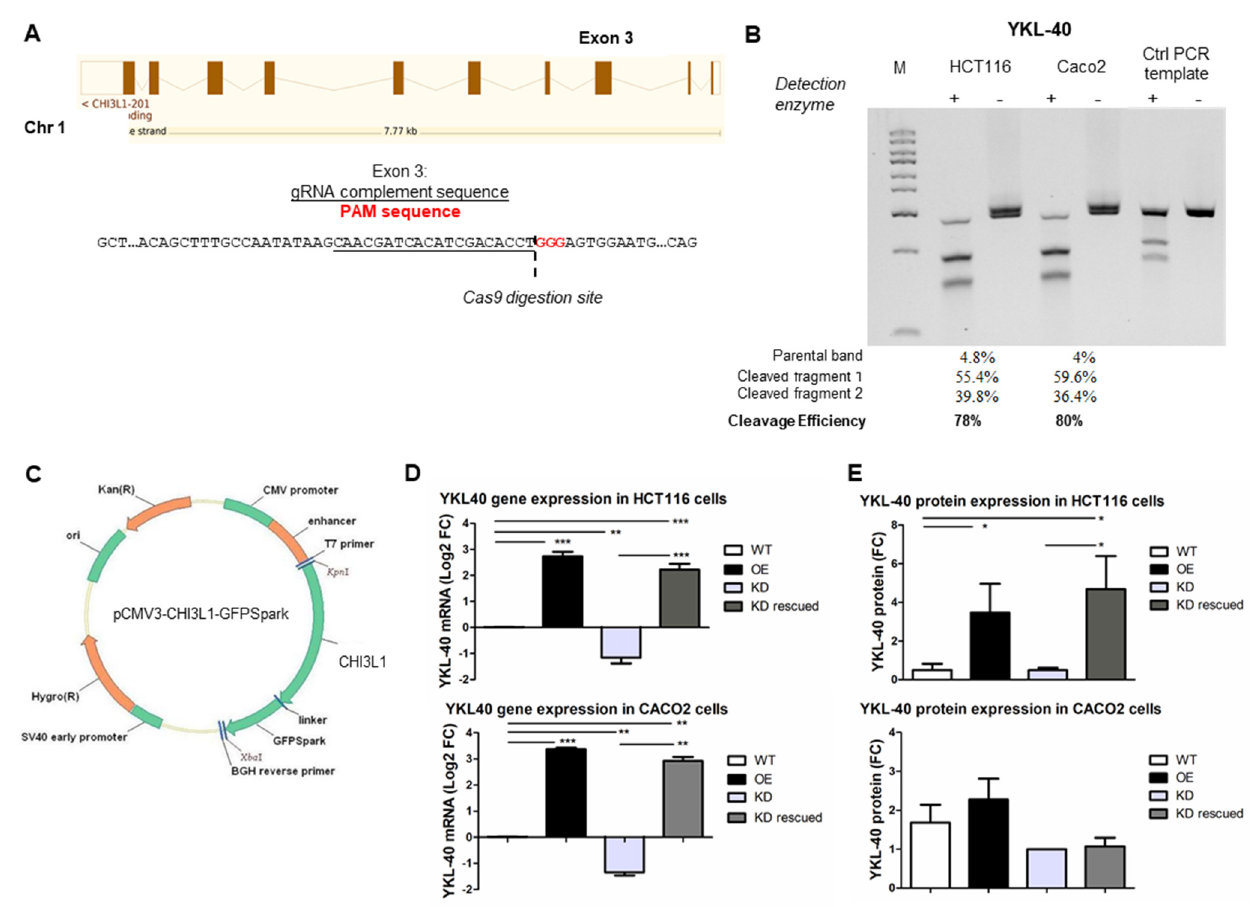
Figure 1. Knockdown and re-/overexpression of YKL-40 in HCT116 and Caco2 cells. ( A ) Knockdown via CRISPR/Cas9 approach is described. Human YKL-40 is located on chromosome 1. The exon 3 sequence is reported, the gRNA complement sequence is underlined, and the PAM sequence is indicated with red nucleotides. ( B ) Gel image of Genomic Cleavage Detection Assay using DNA extracted from transfected HCT116 and Caco2 cells. Control template and primers were included as a PCR technical control. Cleavage efficiency is indicated for each sample. ( C ) Map of pCMV- CHI3L1-GFPSpark plasmid used for YKL-40 gene expression. Validation of YKL-40 knockdown and re-/overexpression at ( D ) mRNA and ( E ) protein levels in both cell lines. qPCR data and densitometric data are shown as mean ± SD. Statistically significant differences were calculated using Student’s t test: *, p < 0.001; **, p < 0.01; ***, p < 0.0001. Data represent three independent experiments.